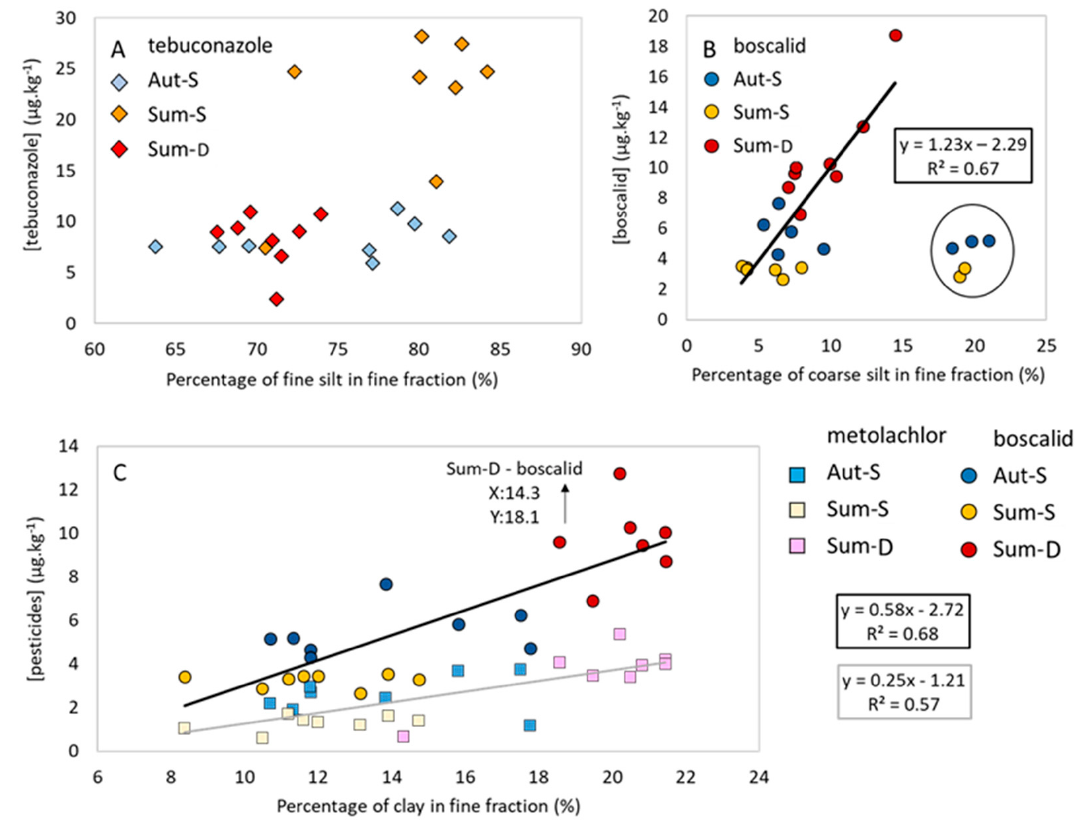
Figure 2. Relationships between pesticide concentrations in sediments (in µ g · kg − 1 ) and the percentage of the different granulometric fine fractions for the different sampling seasons (Sum: summer; Aut: autumn) and depths (S: surface sediment; D: deep sediment). ( A ) tebuconazole versus fine silts, ( B ) boscalid versus coarse silts, ( C ) boscalid (circles) and metolachlor (squares) versus clays. All percentages are relative to the total fine fraction (<63 µ m). The linear regressions of the set of points are represented by black lines for boscalid ( B ), excepted encircled outliers and ( C ), except one sample out of Y-axis) and grey line for metolachlor ( C ).